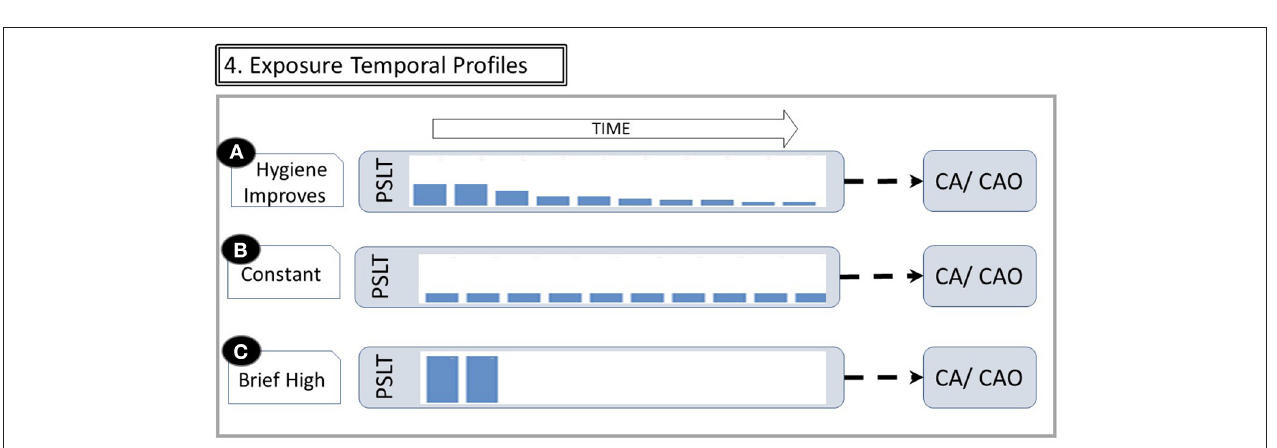
FIGURE 4 | Exposure temporal profiles. The figure illustrates that the same cumulative dose may be received with different temporal patterns. (A) If exposure controls improve over time, long tenure workers have a relatively high exposure early in their career and then much less later. (B) Constant moderate exposure. (C) Extremely heavy exposure for short duration, then leaving industry with no subsequent exposure (Abbreviations are the same as in Figure 1 ). Changes in exposures over time are reflected by the height of bars within the PSLT